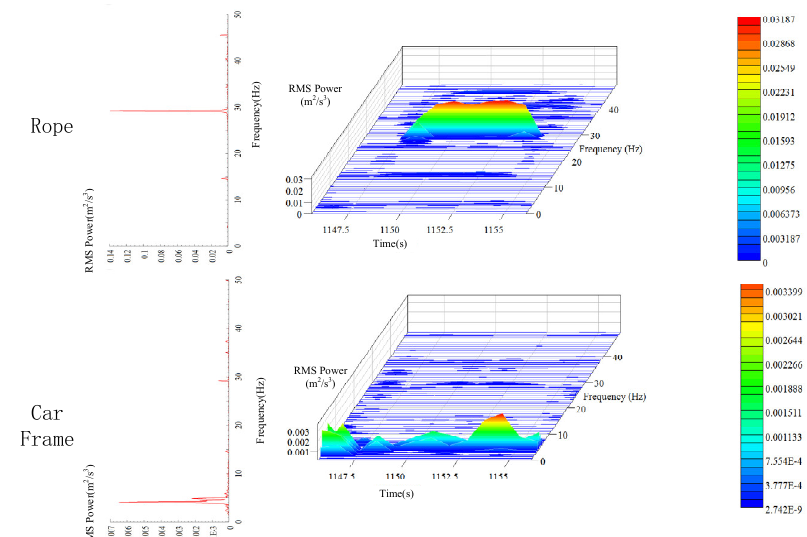
Figure 16. Comparison of time-frequency characteristics between the hoist rope and car frame above 1 Hz.